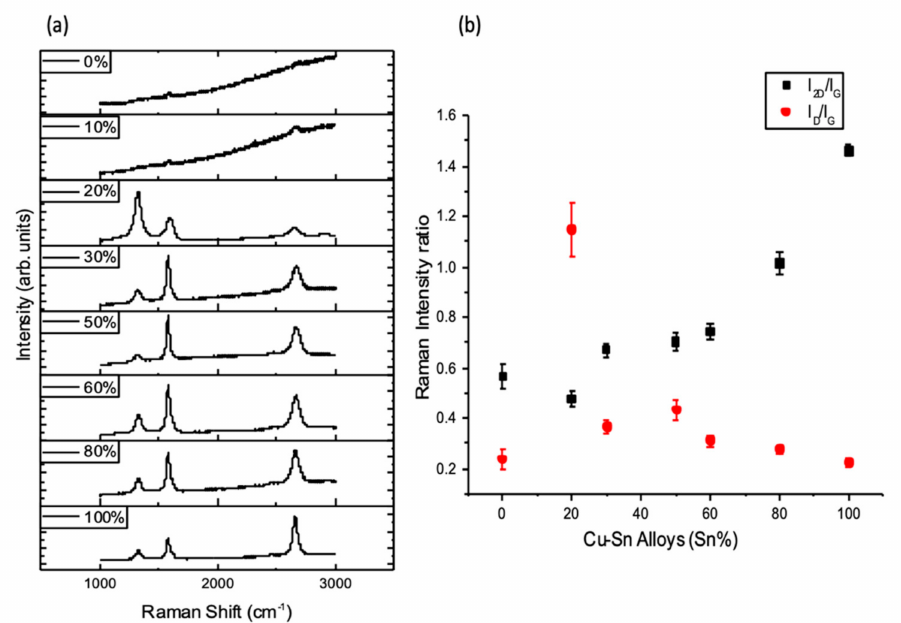
Figure 7. ( a ) Raman spectra of points taken randomly on the surface of the deposited film for the di ff erent Cu–Sn compositions (Sn%). ( b ) A plot of the average Raman intensity ratios based on > 100 points Raman maps, I / I / I 2D G and I D G vs. the wt.% content of Sn in each Cu–Sn composition (error bars are smaller than some data points) (APCVD, T = 1120 ◦ C, 25 H 2 / 250 Ar / 5 CH 4 sccm, t = 5